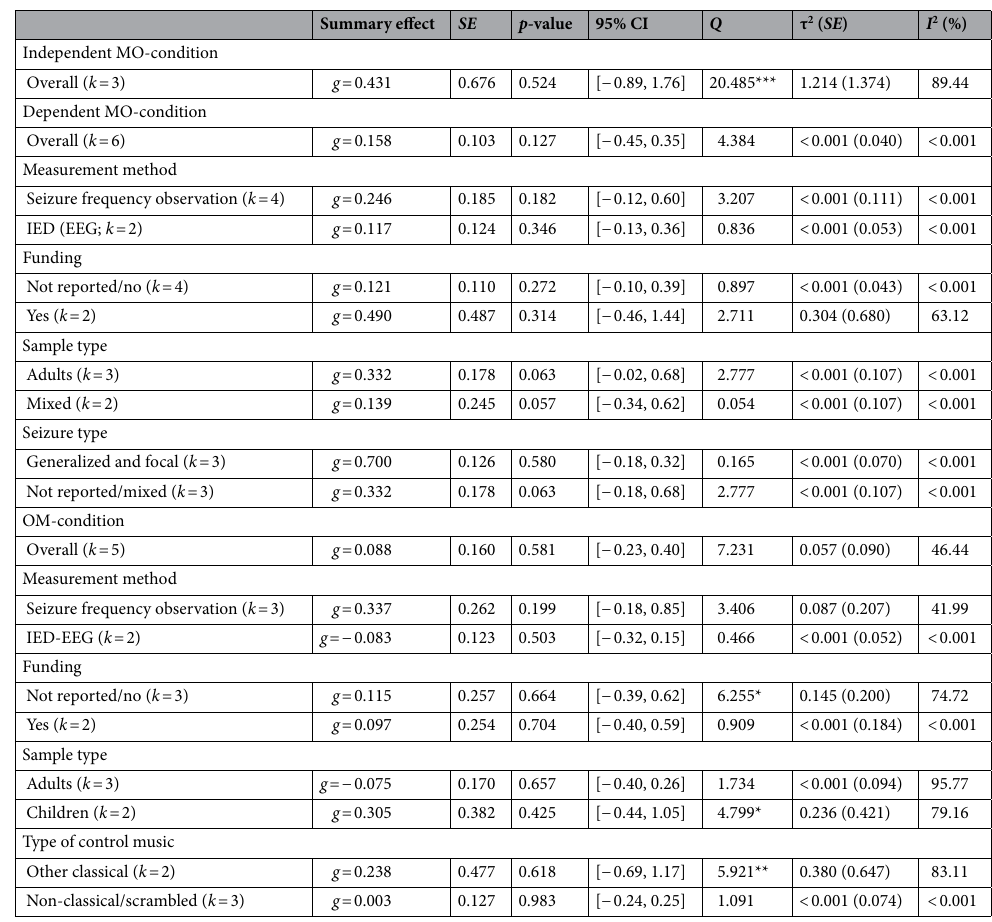
Table 3. Summary effects for overall and subgroup analyses for three independent meta-analyses. Independent MO = independent-groups pretest–posttest designs examining KV448 versus silence 11,27,28